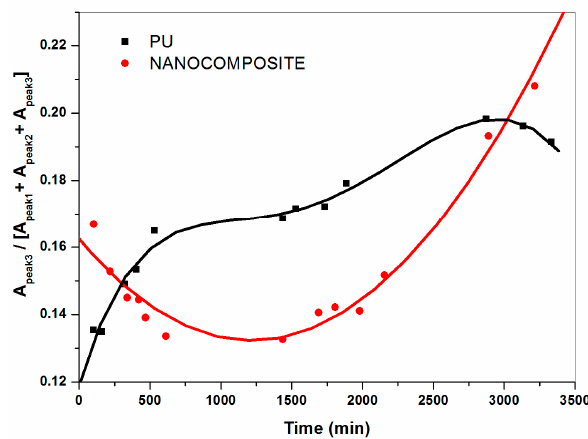
Figure 8. Relative fraction of not bonded water for plain (carbonate urethane) and TiO 2 /poly (carbonate urethane) nanocomposite against the time.